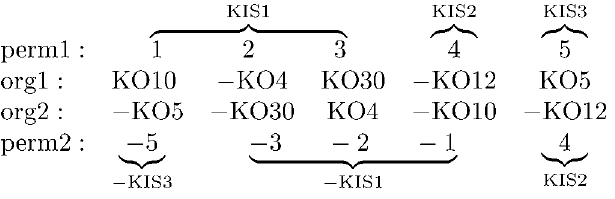
Figure 4. Renaming Common Anchors in Genomes org1 and org2 to Permutations perm1 and perm2 (Step 1 of the Preprocessing Phase) The genome org1 is renamed to the identity permutation (perm1) and the genome org2 is renamed accordingly. Runs of consecutive numbers in perm2 are combined (with respect to their signs) into KISs. A negative sign preceding a KO indicates that the KO is coded on the complementary strand. A negative sign preceding a permutation element indicates that its orientation is not identical in both genomes.